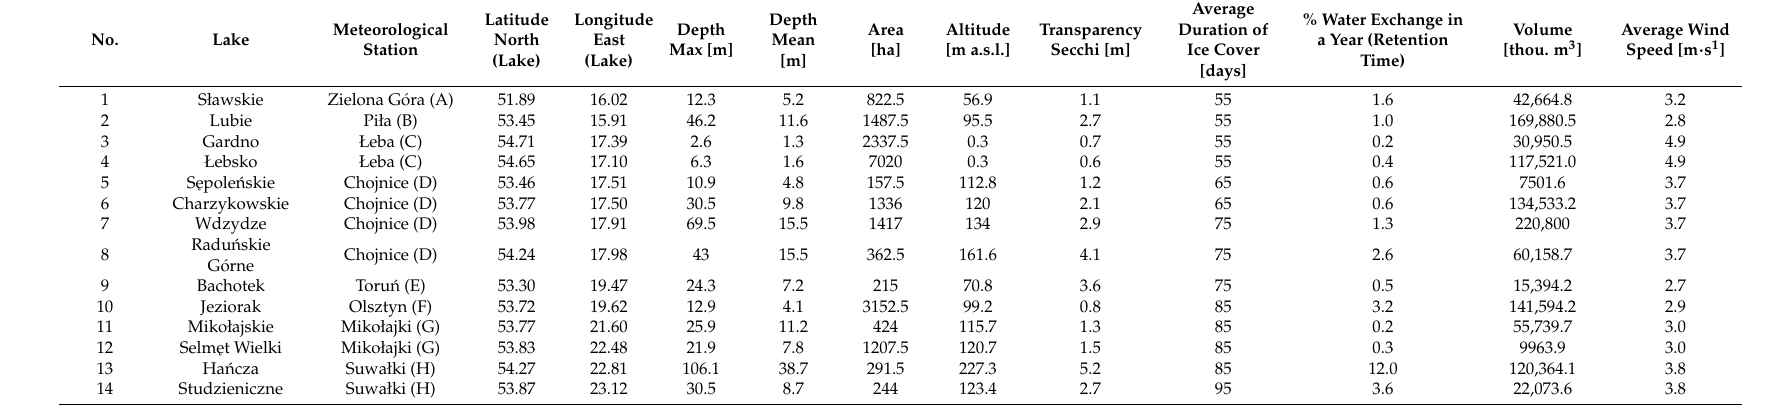
Table 1. Parameters of the analysed lakes (numbering in accordance with Figure